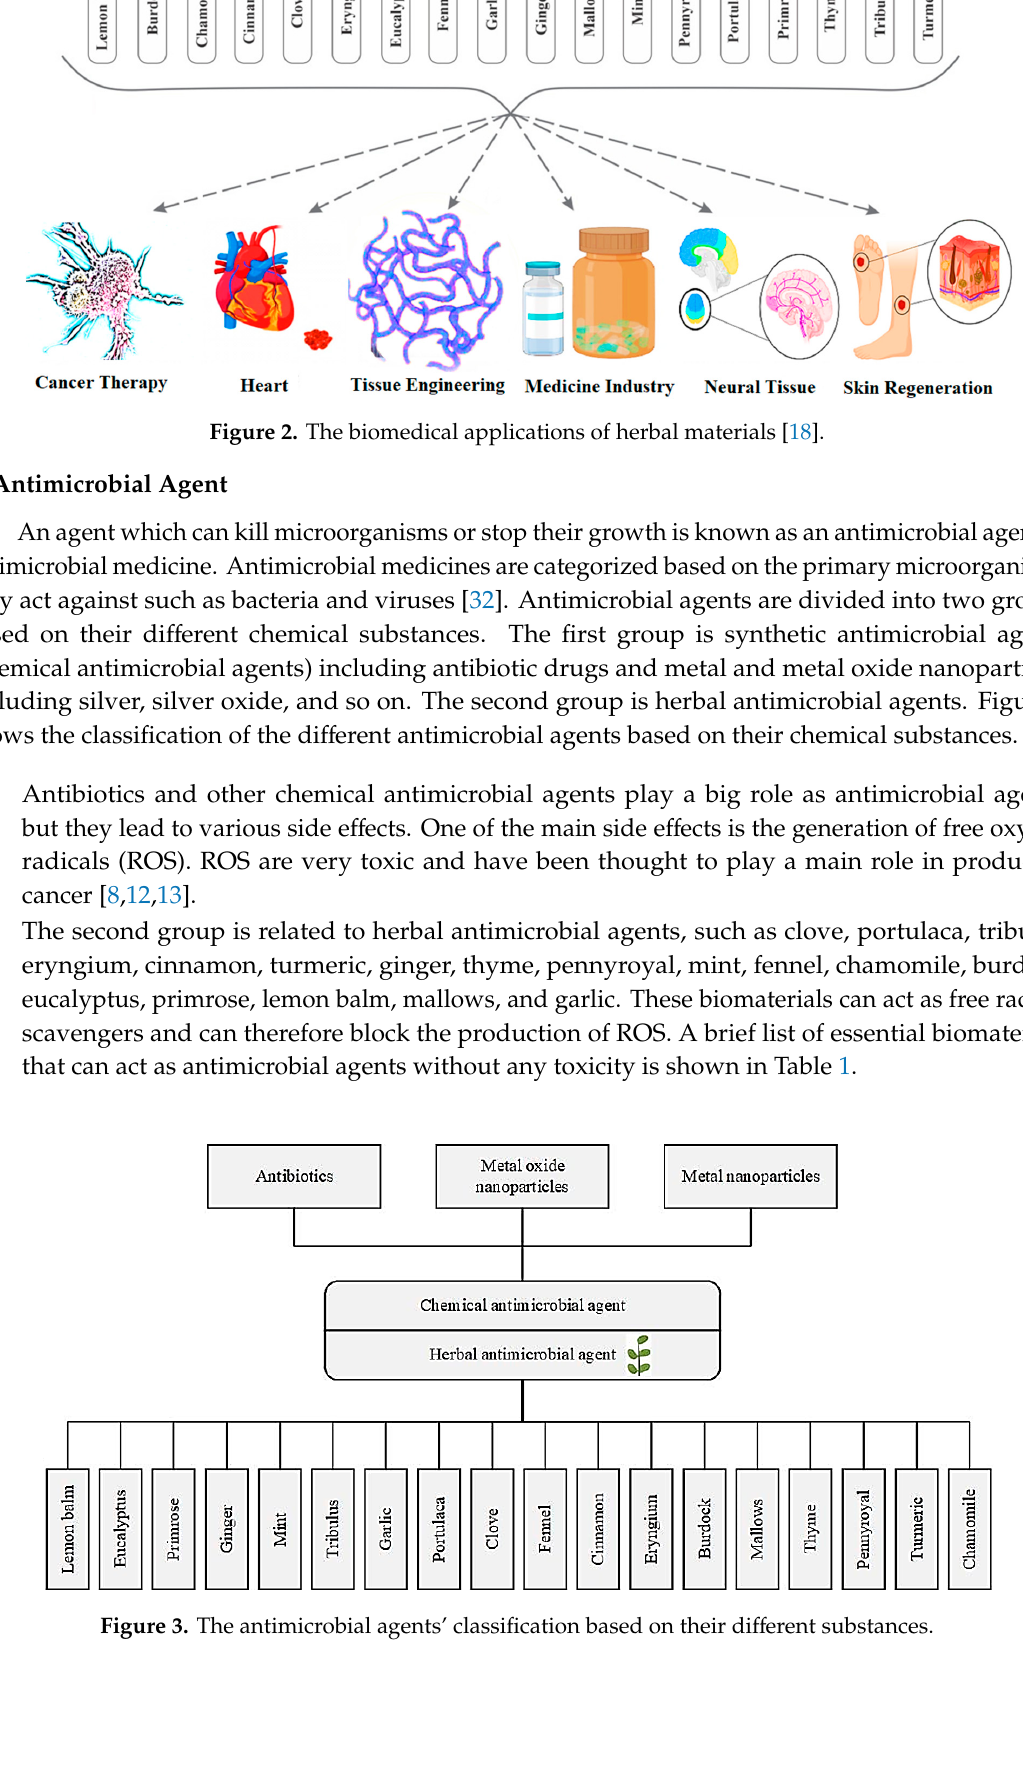
Figure 4. The antimicrobial mechanisms of herbal antimicrobial agents (A) against chemical antimicrobial agents (B) [34,35].